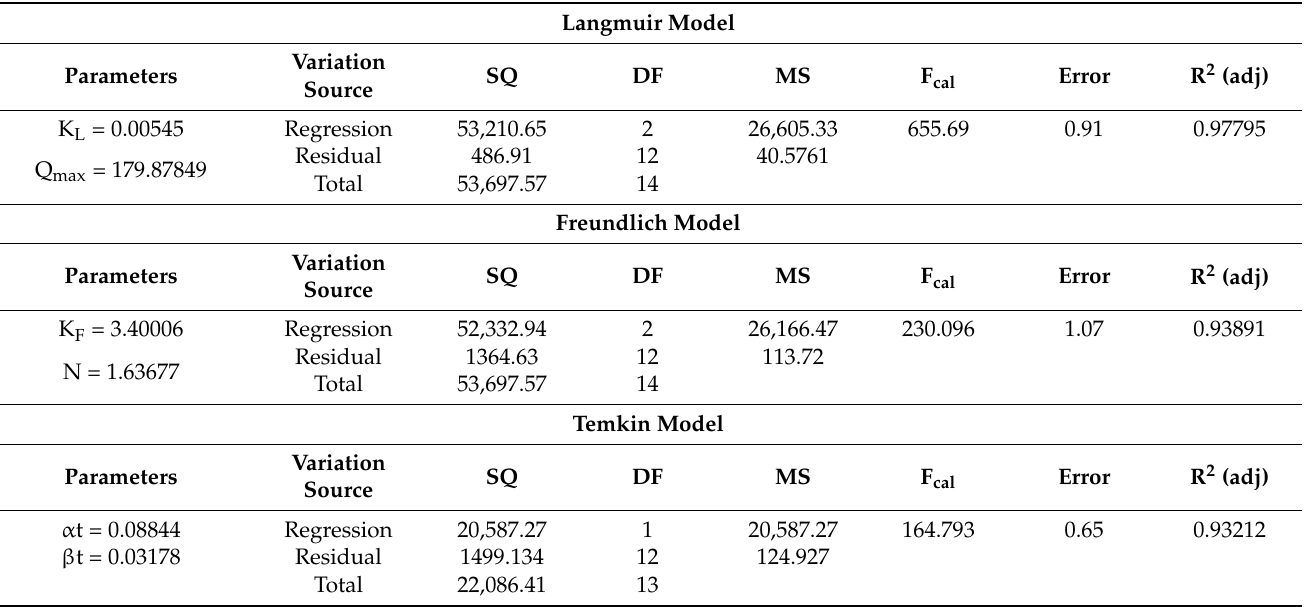
Table 10. Parameters and ANOVA obtained experimental data of SD adsorption in acid- functionalized sample fitting to the isotherm models of Langmuir, Freundlich and Temkin. Langmuir Model